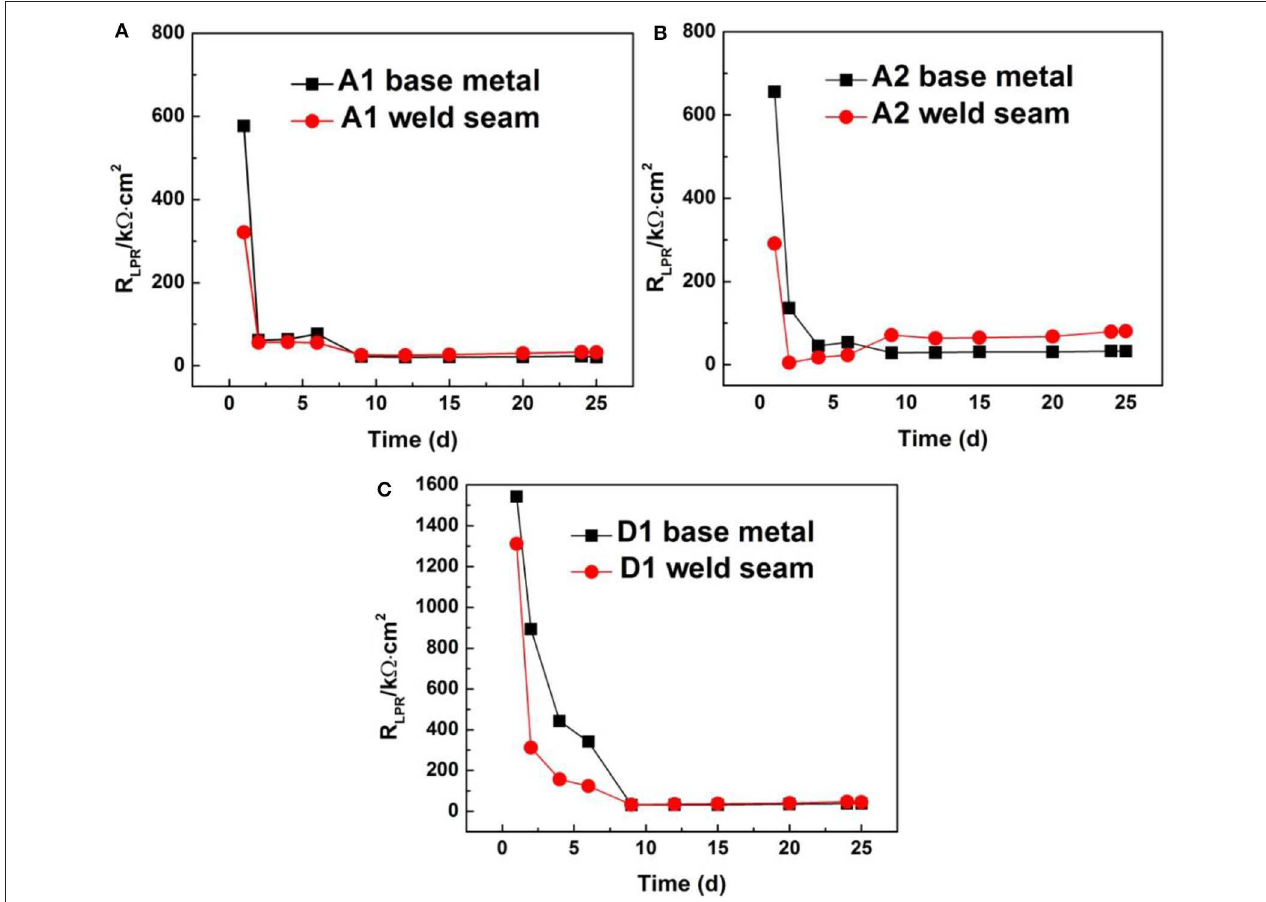
FIGURE 7 | Variation in linear polarization resistance with exposure time for three stainless steels: (A) A1 steel, (B) A2 steel, and (C) D1